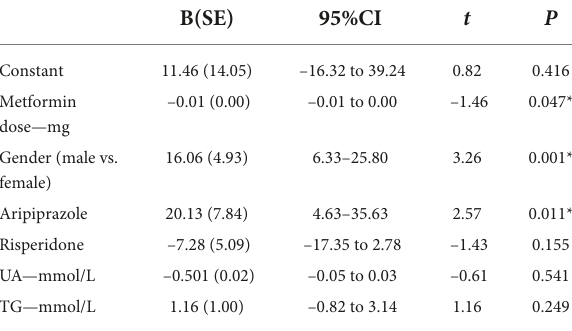
TABLE 4 Influencing factors of prolactin levels in patients with diabetes mellitus: multiple linear regression